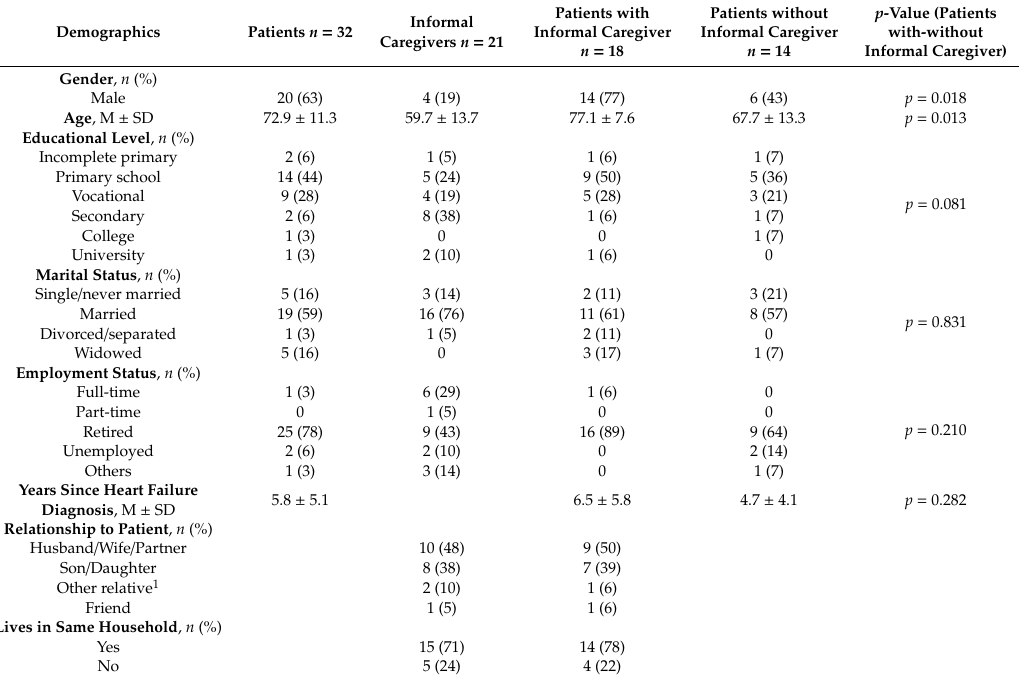
Table 2. Participant